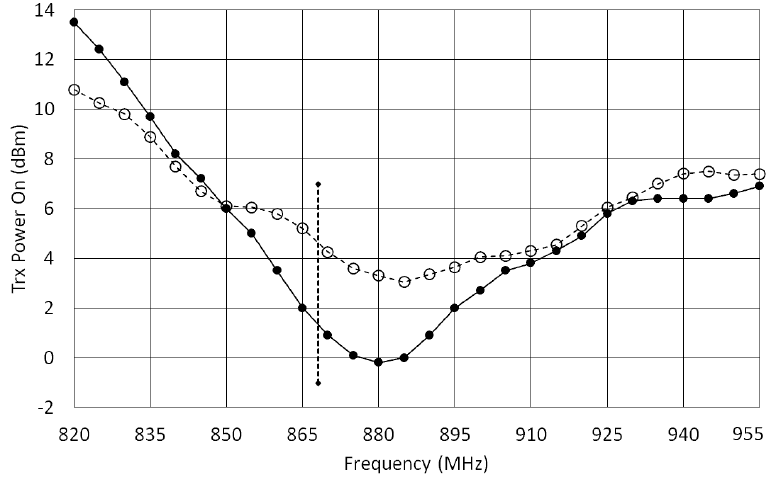
Figure 2. Transmission power to turn on the tag (for H = 26 mm) as a function of frequency. Solid line is for wet soil and dashed line is for dry soil. The cursor marks the frequency of 868 MHz. Adopting the frequency of 868 MHz, a second test was made to evaluate the tag’s behavior as a function of the height H , with measurements obtained for H from 1 to 60 mm over both dry and wet soil, as shown in Figure 3. When the tag is very close to the soil ( H lower than 5 mm) the transmission power P TagOn is greater than 12 dBm for both soil situation (dry and wet), thus the tag becomes insensitive. Of course, for greater heights the sensor tag will be also insensitive. A maximum sensitivity is obtained when the tag is placed 10 to 30 mm above the soil, as can be seen in Figure 3.